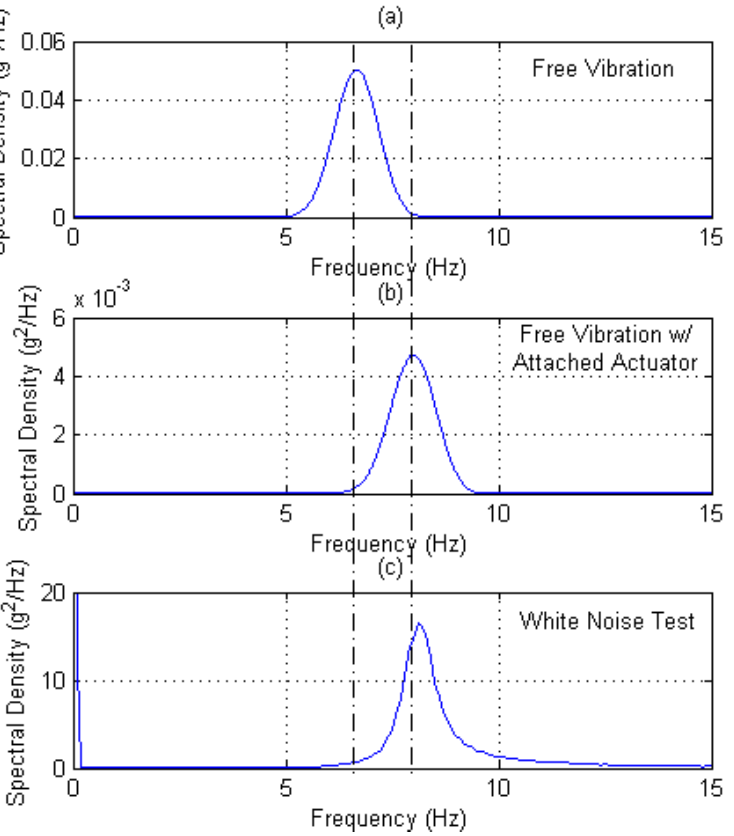
Figure 18. Comparison of dynamic responses (using signal filtering to remove non-tower modes) of a monopile foundation gained using: ( a ) standard free vibration method, ( b ) free vibration method with attached actuator rod, and ( c ) white noise method.